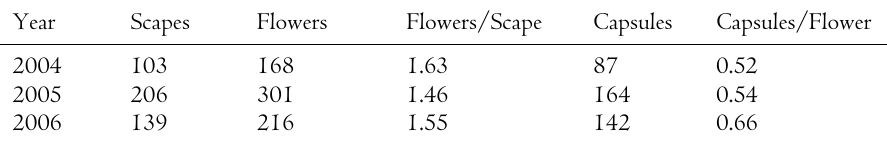
Census of flowering and fruiting scapes at ECCO (2004 – 2006).